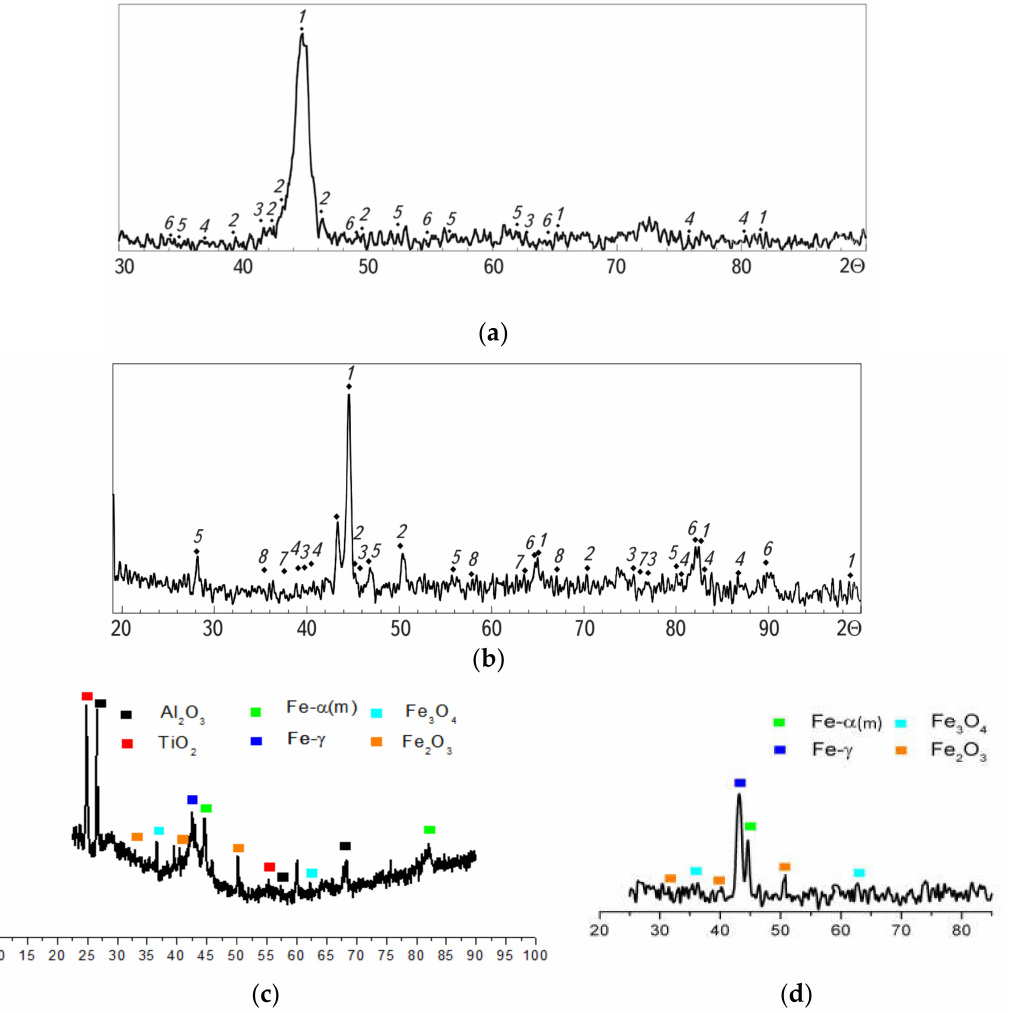
Figure 6. X-ray diffraction patterns of arc coatings obtained with CW: ( a ) No. 1: 1—Fe α (m); 2—(Fe, Cr) 3 C; Traces: 3—(Fe, Cr) 23 C 6 ; 4—(Fe, Cr) 7 C 3 ; 5—Fe 2 O 3 , and 6—Al 2 O 3 ; ( b ) No. 2: 1— Fe α (m) ; 2— Fe γ (residual austenite); 3— FeCr; Traces: 4— (Fe, Cr) 3 C 6 ; 5— CaF 2 ; 6— FeO; 7— Cr 2 O 3 ; and 8— Al 2 O 3 ; ( c ) No. 3, and ( d ) No. 5. The CW numbers correspond to those given in Table